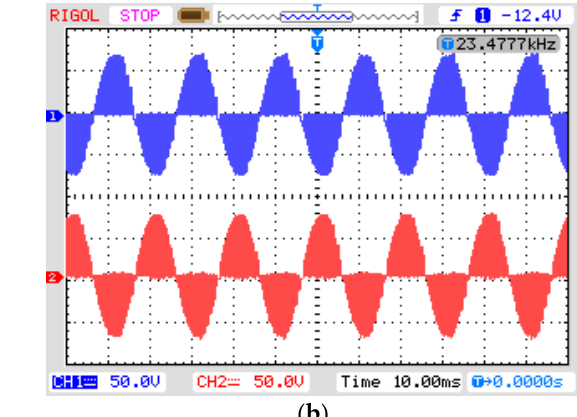
Figure 16. Practically obtained results of output voltage (red) with respect to input (blue) for output step-up process in ( a ) non-inverted form and ( b ) inverted form.